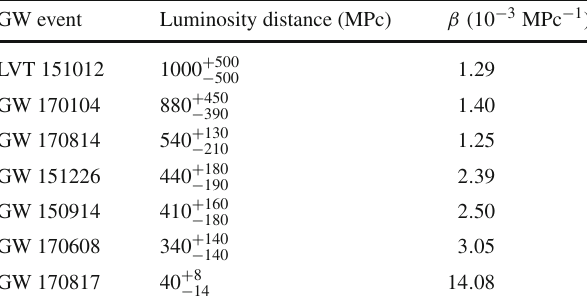
Table 1 Luminosity distances of different GW